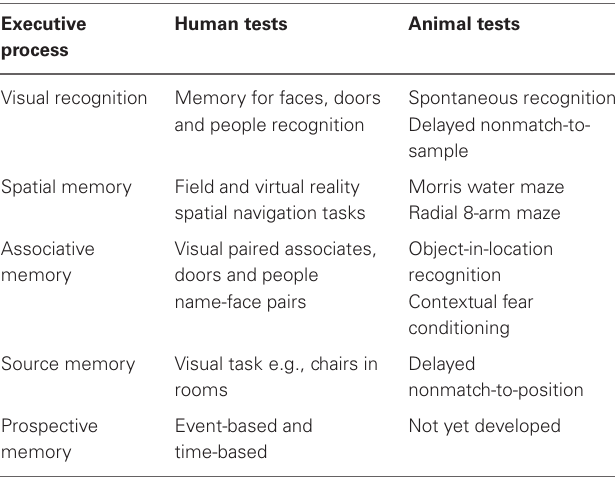
Table 2 | Human memory tests and promising analog tests currently utilized in animal models of